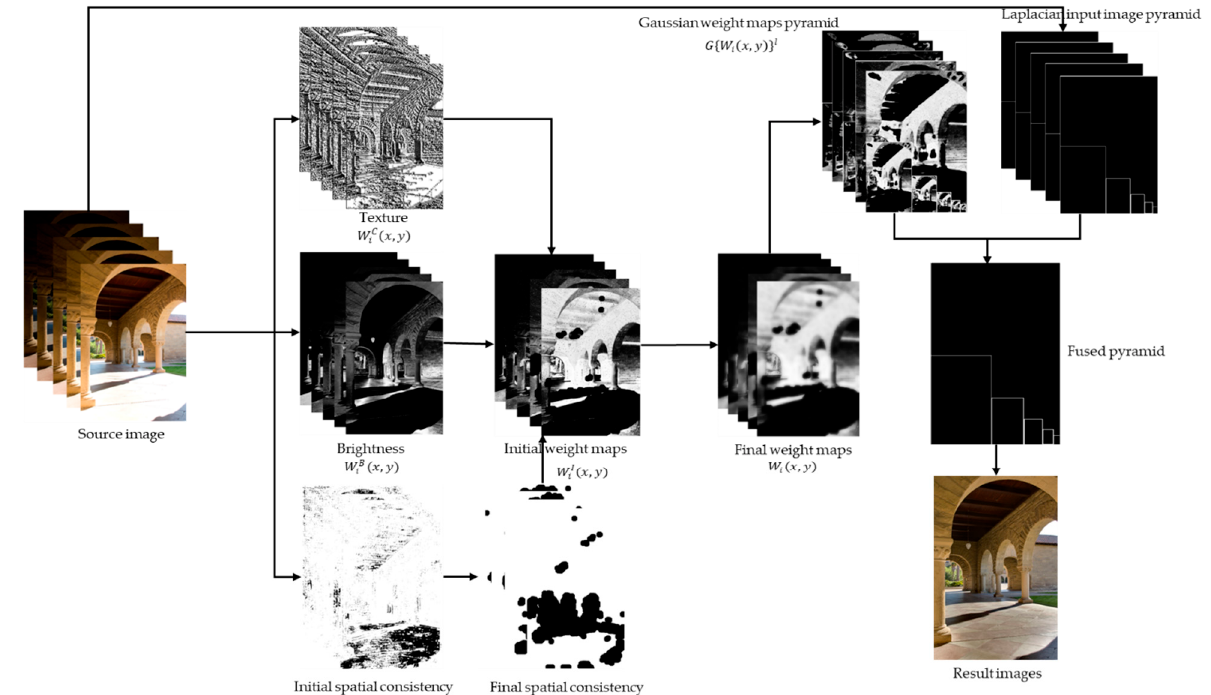
Figure 1. Overall flow diagram of the proposed method.